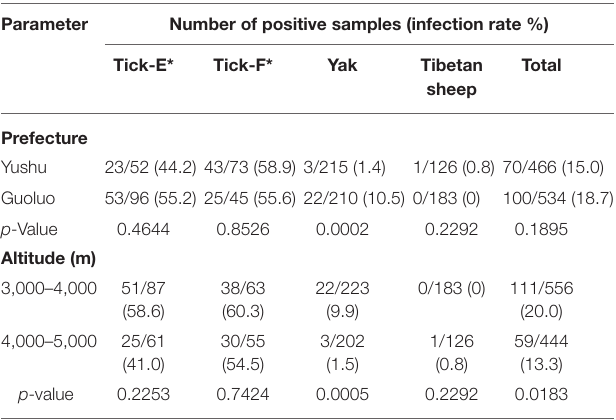
TABLE 4 | The infection rate of spotted fever group (SFG) Rickettsia in engorged